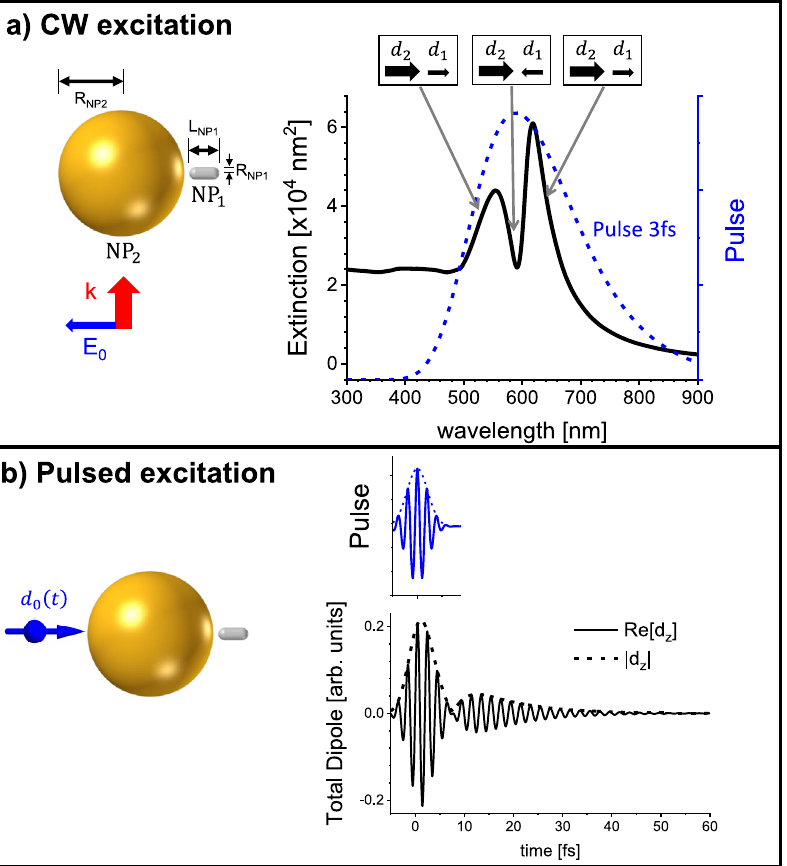
Figure 3: Dynamic properties of the Au – Ag Fano dimer. (a) Extinction of the dimer for the electromagnetic CW excitation. Here, we also show the structure of the induced dipoles in the dimer, which leads to the FE. (b) Dimer ’ s time dynamics under the dipole excitation for a pulse with λ 0 = 589 nm. We used R Au = 50 nm, R Ag = 5 nm, L Ag = 27 nm, gap = 4 nm, and a pulse of Δ t = 3 fs. The spectrum for the dipole excitation pulse is shown in